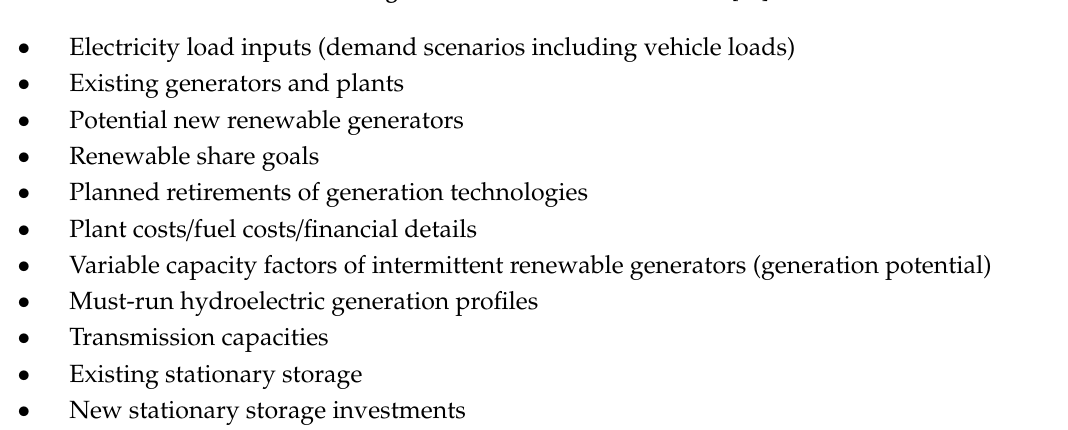
Figure 3. SWITCH Model Overview [12].